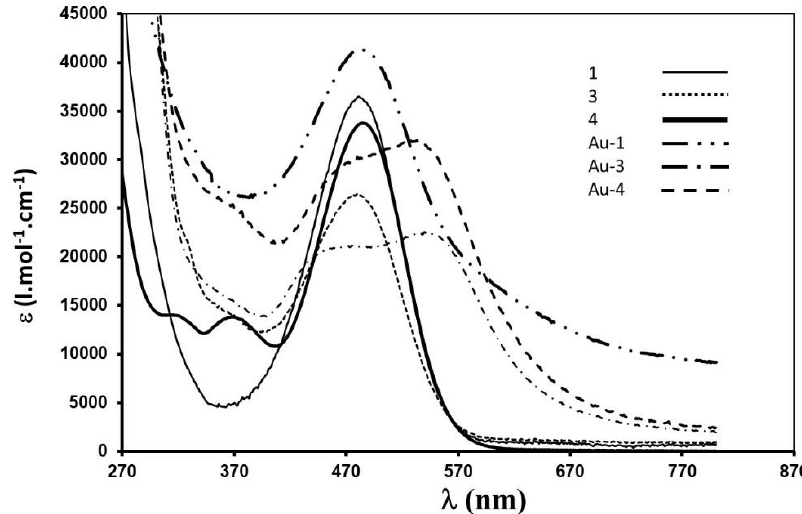
Figure 1. UV–visible absorption spectra of molecules 1 (continuous line), 3 (dotted line) , 4 (thick, continuous line), dye-functionalized nanoparticles Au-3 (dotted-dashed line) and Au-4 (dashed line), and the Au-1 sample made of a mixture of 1 and Au-SPh without link between dye 1 and gold nanoparticle (double-dotted-dashed line) .